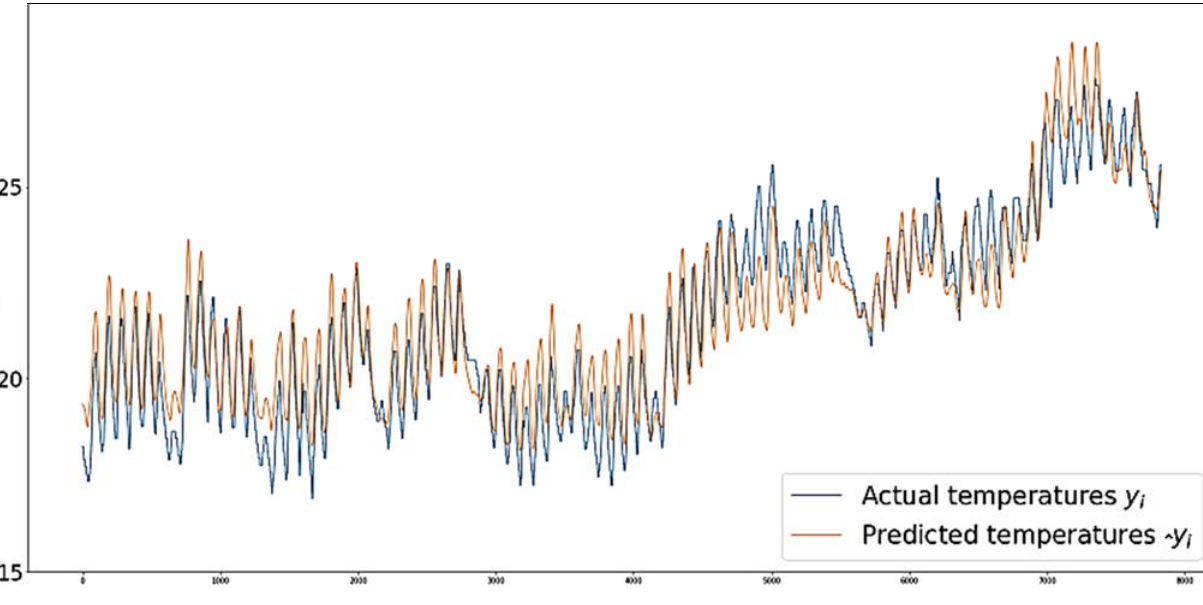
Figure 21. Plot of actual and predicted temperatures 24 h ahead for office 40 on the first floor.